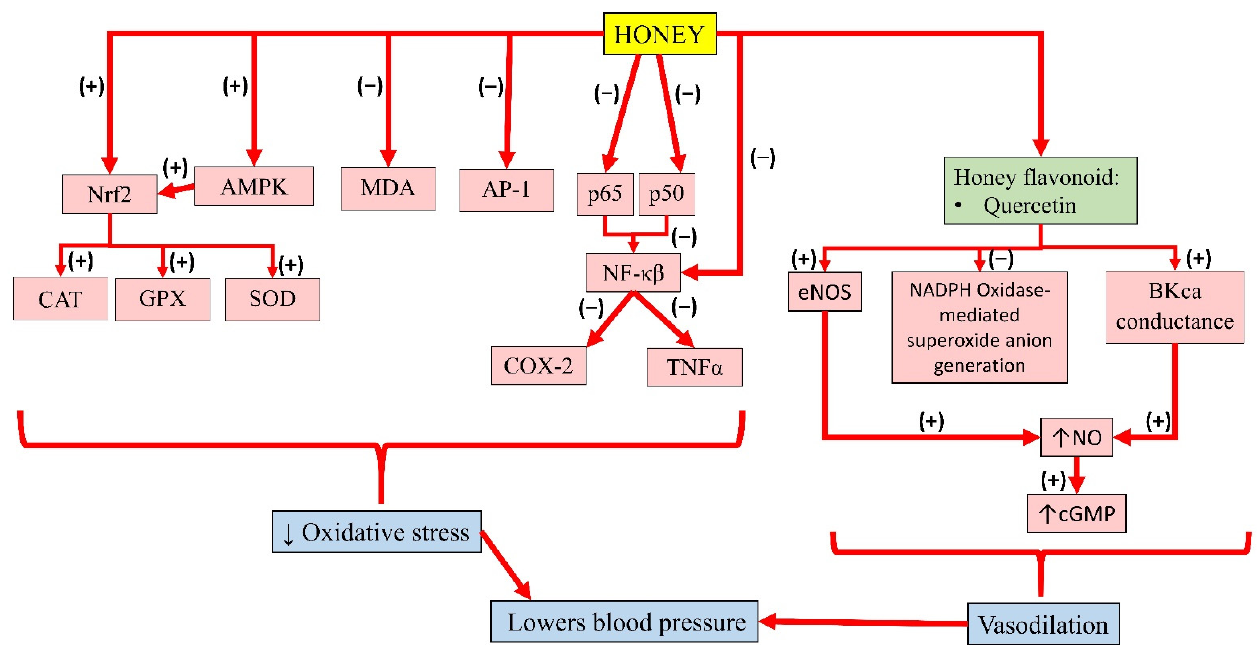
Figure 4. Summary of the antihypertensive properties of honey. Nrf2, nuclear factor erythroid 2-related factor 2; AMPK, 5 ′ adenosine monophosphate-activated protein kinase; MDA, malondialdehyde; AP-1, activator protein-1; p65, subunit 65 protein of NF- κ B; p50, subunit 50 protein of NF- κ B; NF- κ B, nuclear factor kappa B; CAT, catalase; GPX, glutathione peroxidase; SOD, superoxide dismutase; COX-2, cyclooxygenase-2; TNF α , tumour necrosis factor-alpha; eNOS, endothelial nitric oxide synthase; NADPH, nicotinamide adenine dinucleotide phosphate; BKca, large-conductance calcium-activated potassium channel; NO, nitric oxide; cGMP, cyclic guanosine monophosphate; ( − ), inhibit; (+), increase; ↓ , reduce; ↑ , increase.